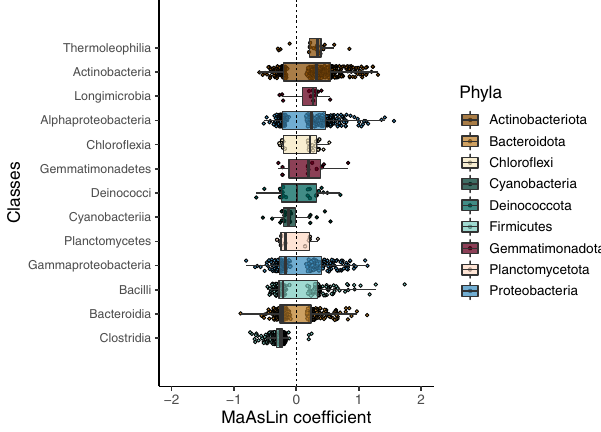
Fig. 5 Bacterial taxa signi fi cantly associated with PM10 concentration. The MaAslin2 scores per class are presented with association to particulate matter concentration. Each color represents a different phylum. Box plot center lines represent the median values, the lower and upper hinges correspond to the fi rst and third quartiles (the 25th and 75th percentiles), the lower and upper whisker extends from the hinge to the lowest and largest value no further than 1.5 * IQR from the hinge, and dots represent ASVs within each group. Bacterial classes with more than ten ASVs associated with PM 10 concentration are